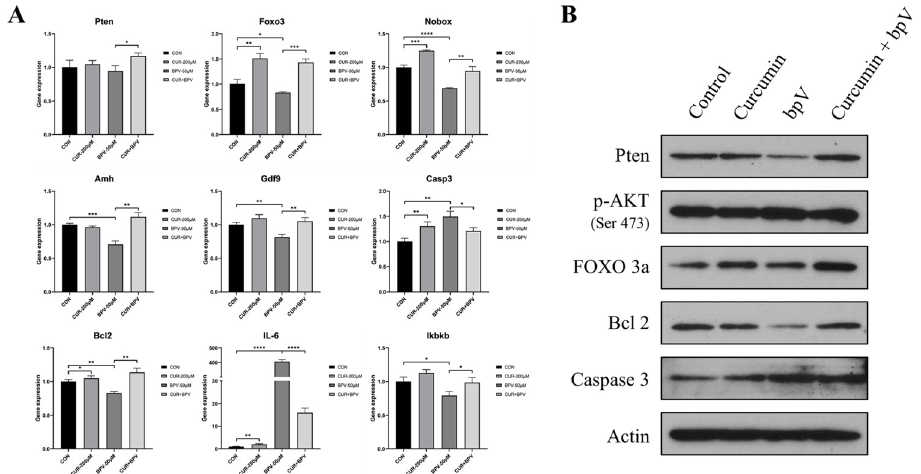
Figure 4. Curcumin protects against follicle overactivation by inhibiting the PTEN-AKT-FOXO3a pathway. ( A ) Gene expression of P3 ovaries cultured with curcumin (CUR) and/or bpV for 2 days. ( B ) Western blot of proteins from ovaries cultured with curcumin and/or bpV for 12 h. * p -value < 0.05, ** p -value < 0.01, *** p -value < 0.001, **** p -value < 0.0001 compared to the corresponding groups.